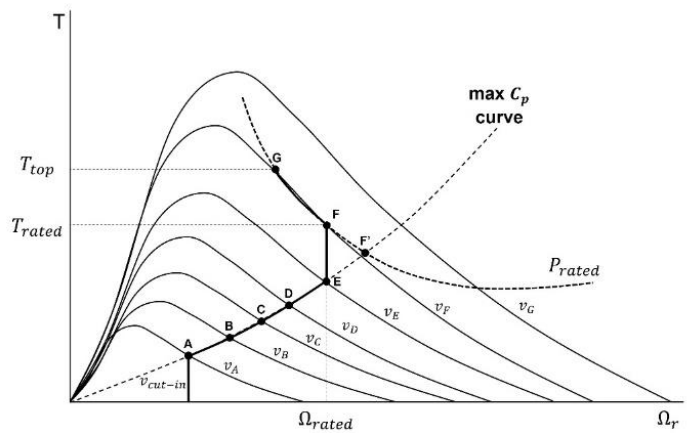
Figure 7. Stall control wind turbine torque, rotational speed diagram.